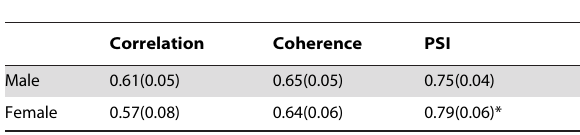
Table 12. Comparison of Classification Accuracy by Using All Frequency Bands Base on Correlation, Coherence and Phase Synchronization Index (PSI) between male and